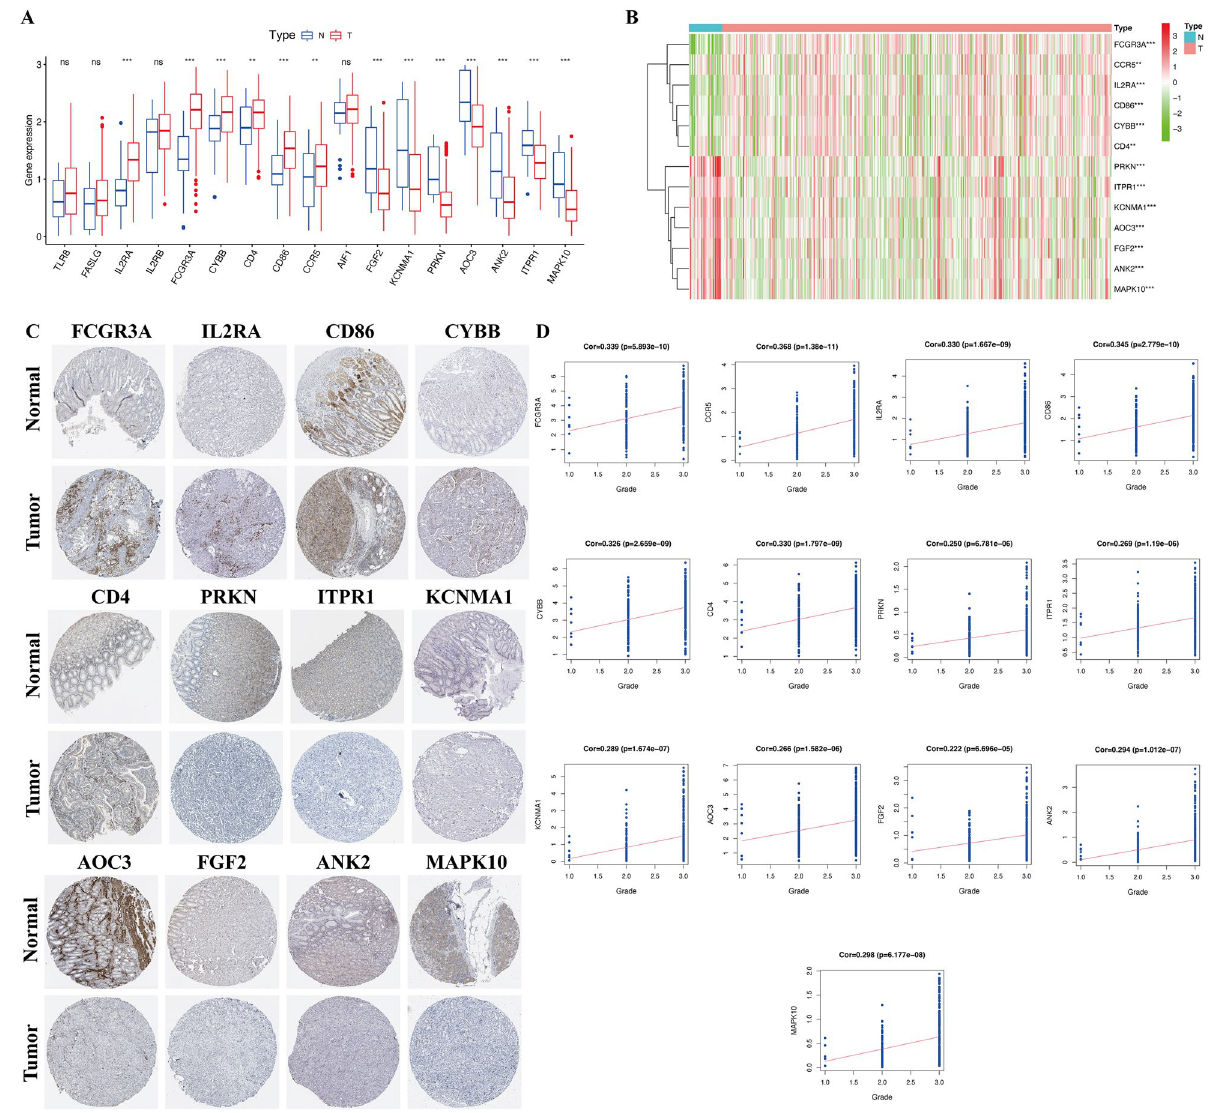
Figure 10. Connections between the expression of progression-associated OS genes and GC grade. ( A ) The mRNA expression pattern of progression-associated OS genes in TCGA cohort. ( B ) The heatmap reveals the transcription expression of progression-associated OS genes in TCGA cohort. ( C ) HPA database verifies the protein expression of hub progression-associated OS genes. ( D ) Correlation analysis between 13 progression- associated OS genes expression and tumor grade.